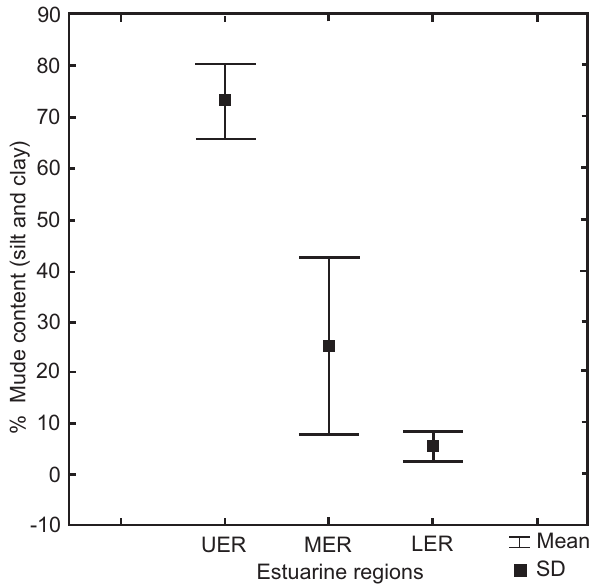
Figure 7. Variation in mud content (silt+clay) in the upper (UER), mid (MER), and lower (LER) estuarine regions of the Rio Formoso. For each estuarine region (n =